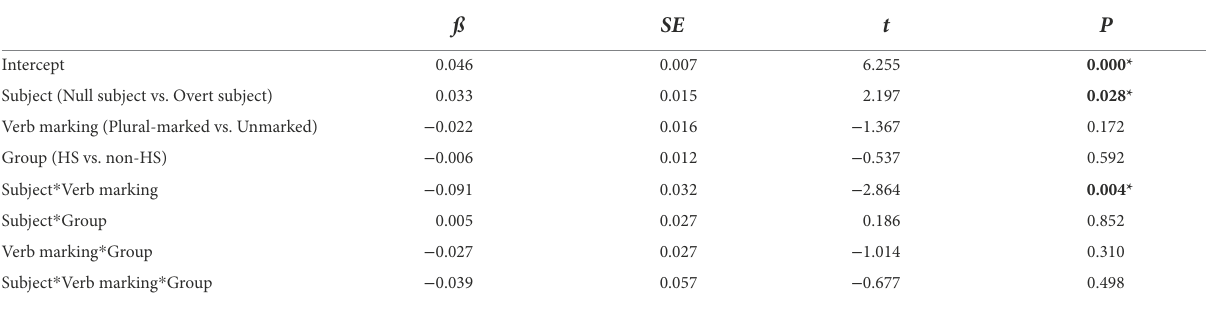
TABLE 4 Linear mixed effects model output for Region 5 (Spillover 1).